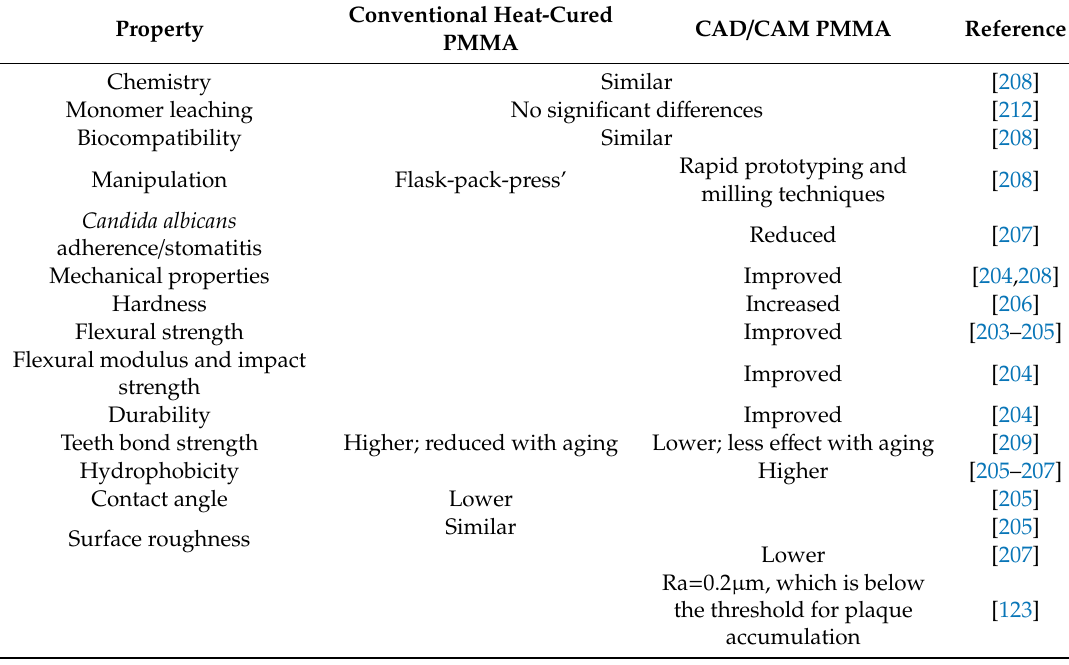
Table 5. Comparison of conventional heat-cured and CAD / CAM PMMA